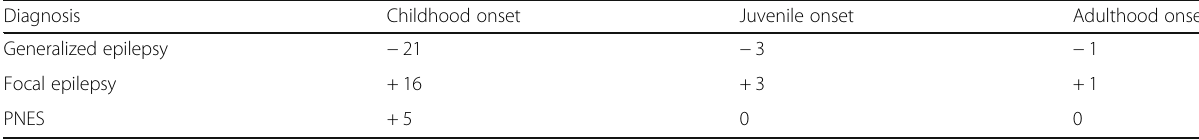
Table 2 Clinical history among patients of both eventful and non-eventful groups Aura Abdominal pain